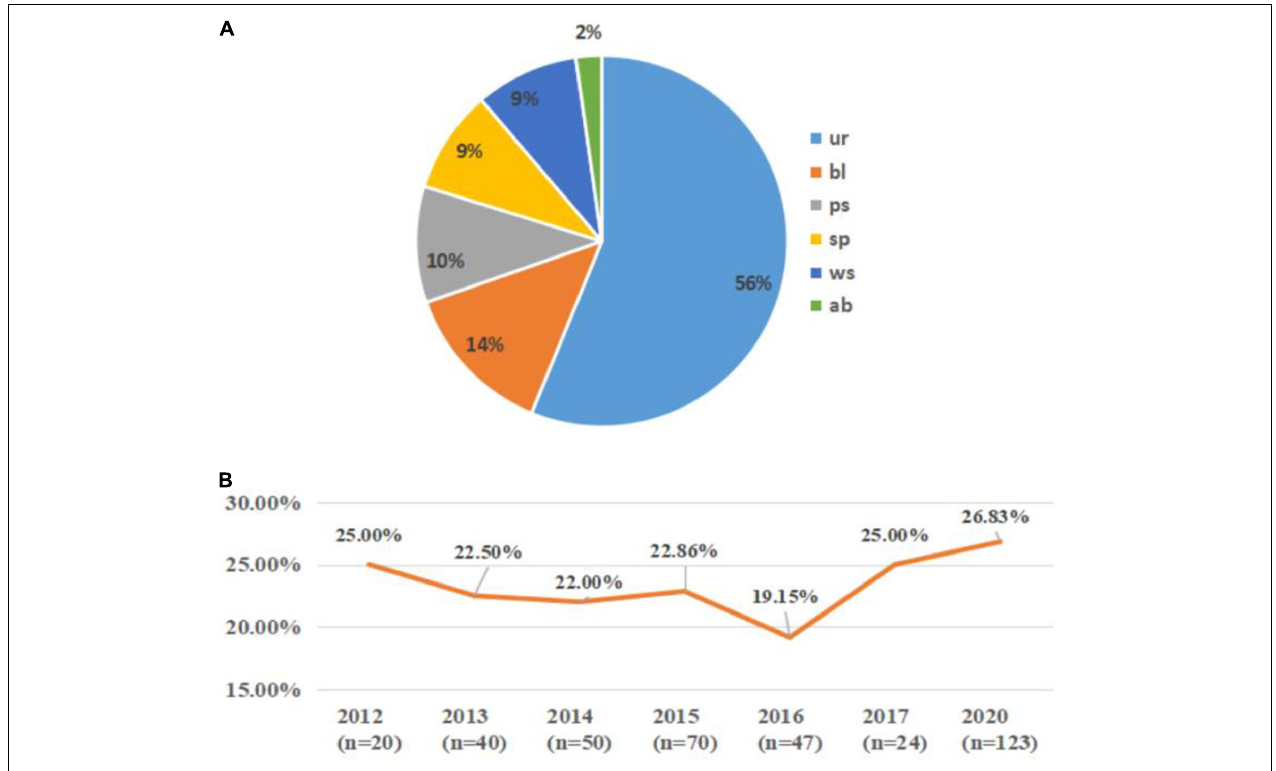
FIGURE 1 | The distribution of specimen sources and collection years of the bla CTX − M − 55 -positive isolates. (A) The specimen source distribution of all the bla CTX − M − 55 -positive isolates. ur, urine; bl, blood; ps, purulent secretion; sp, sputum; ws, wound secretion; ab, abdominal drainage fluid. (B) The collection year’s distribution of the bla CTX − M − 55 -positive isolates among all the isolates. n indicates the number of isolates collected in that year; orange line indicates the